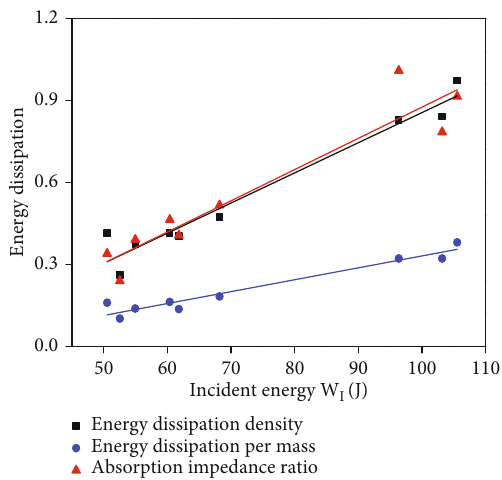
Figure 14: The relationship between energy indexes and incident energy.